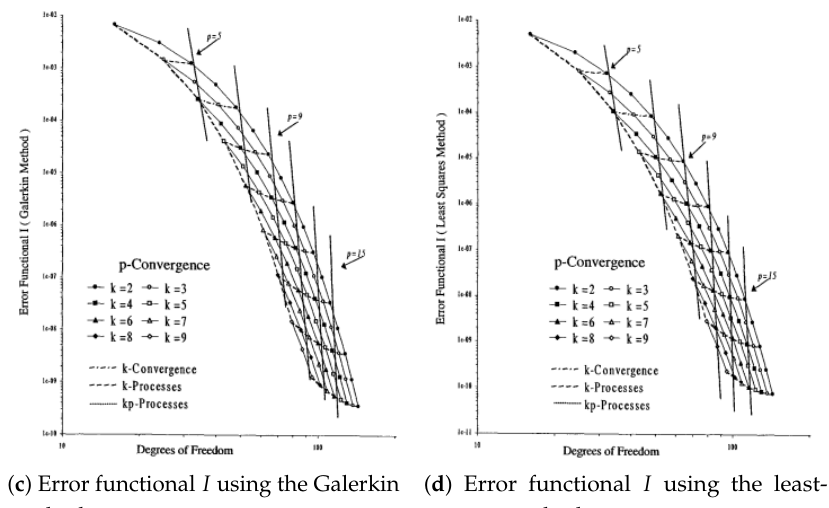
Figure 11. Graphs of π and I versus dof for axial